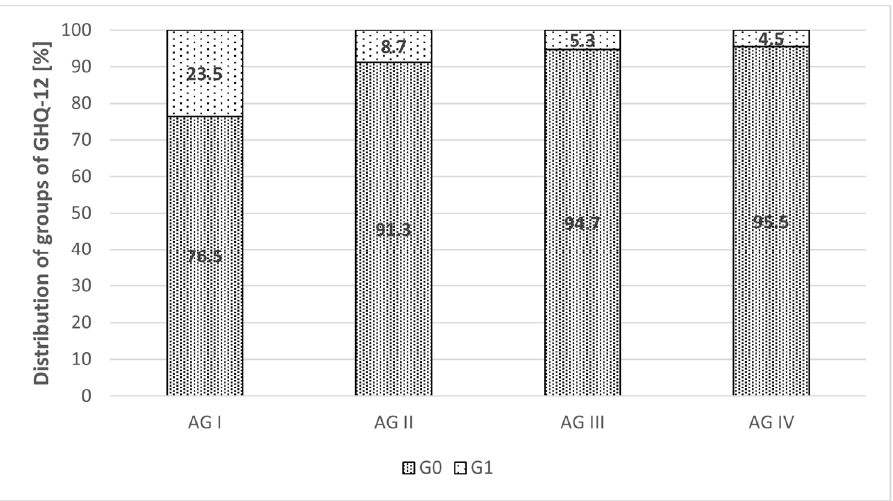
Figure 1. Distribution of groups of GHQ-12. Notes. AG = age group G0 = group with regular mental health, G1 = group with impaired mental